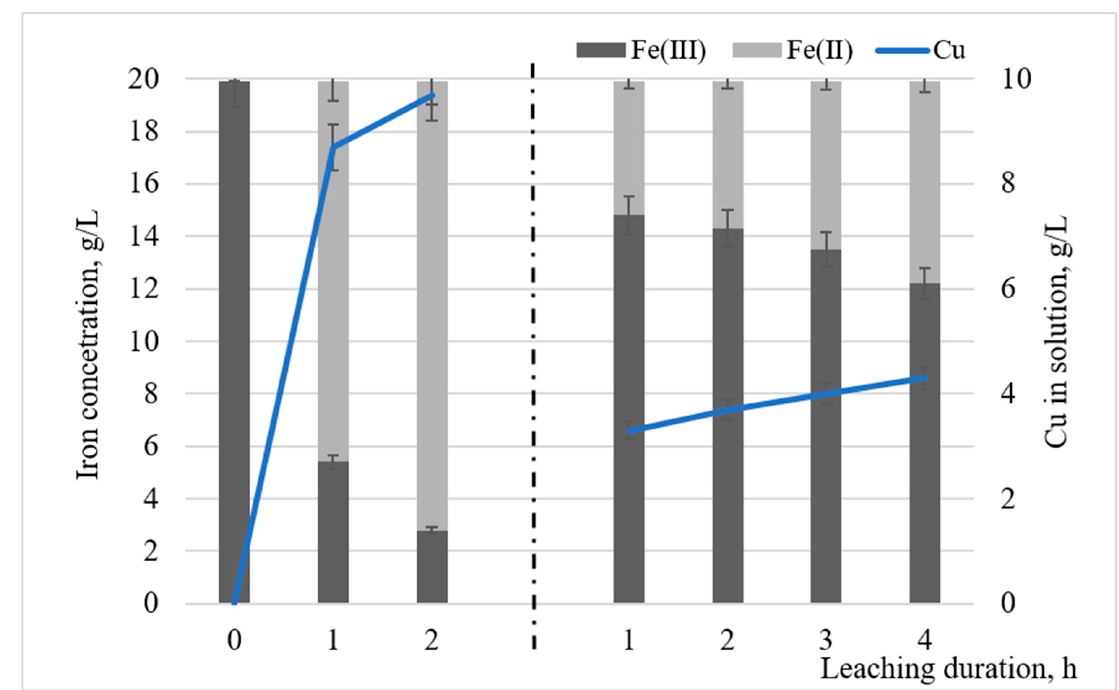
Figure 8. Kinetics of two-stage Cu leaching and iron speciation in the biogenic Fe 3+ system. Table 2. Bacteria enumeration during bioleaching (PD 5%, initial pH-2.0, 20 g/L Fe 3+ , 40 ◦ C, air -1 lpm, 600 rpm, duration-24